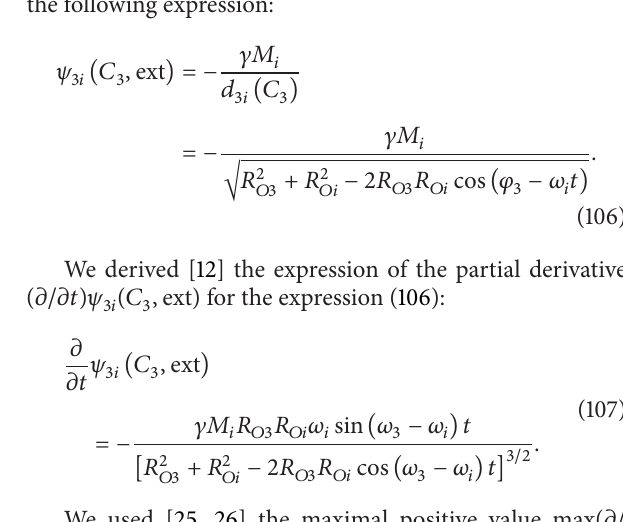
Figure 7: The geometric sketch of circulations of the Earth 𝜏 3 and the inner planet 𝜏 𝑖 (Mercury or Venus) around the mass center 𝑂 of the Sun.